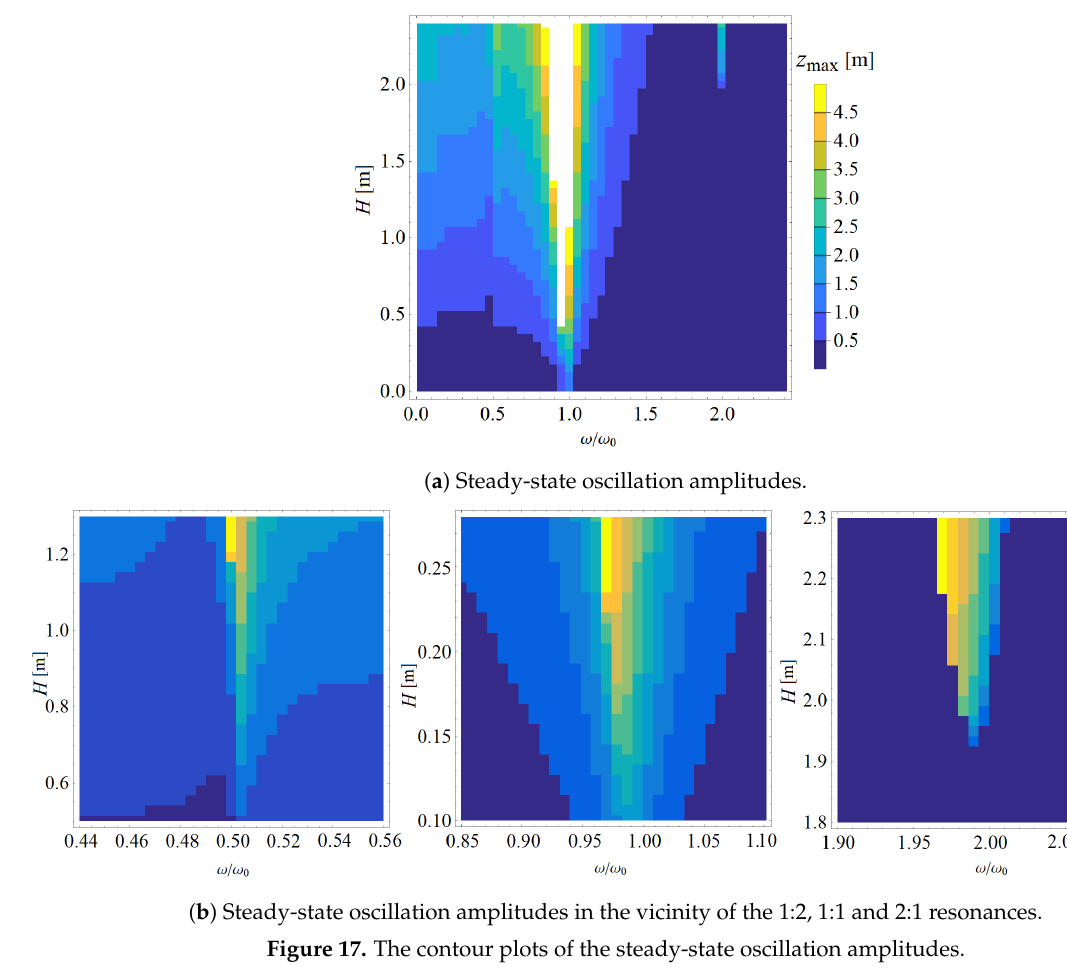
Figure 17. The contour plots of the steady-state oscillation